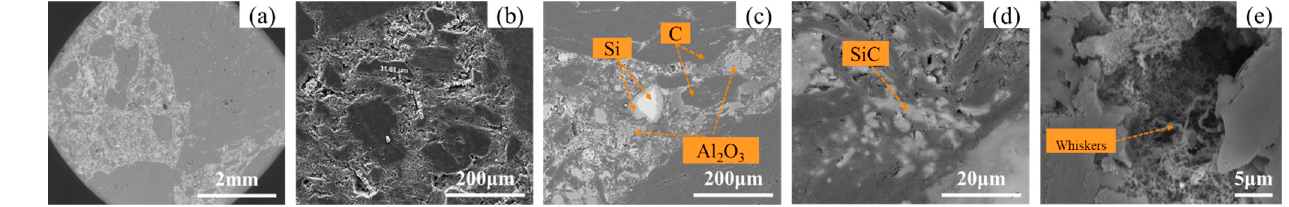
Figure 6. Schematic diagram of sample cutting before and after corrosion.